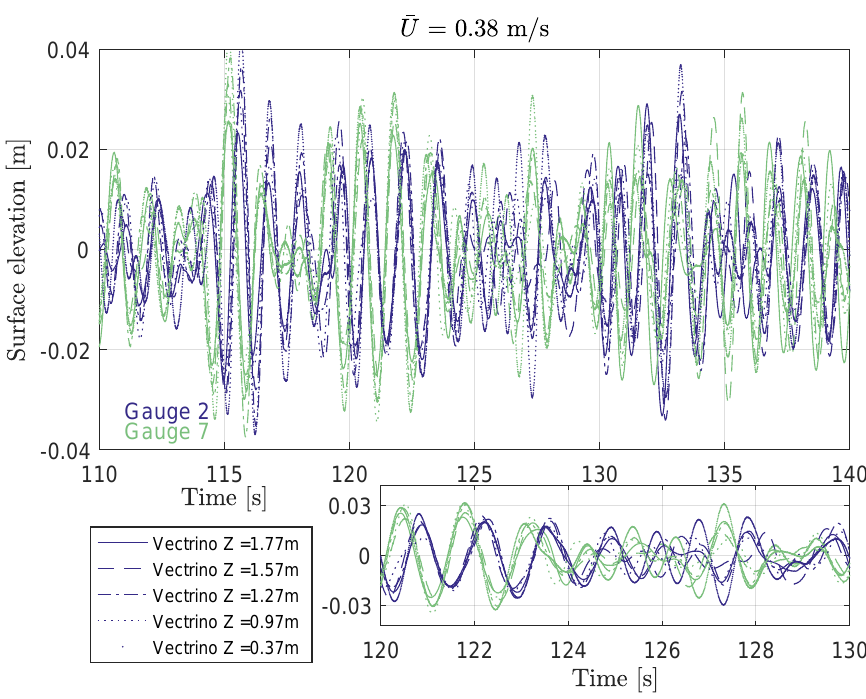
Figure 8. Example time series of irregular wave, Sea State 6, shown with five repeats. Gauges 2 and 7 are displayed on the graph. Wave Repeats 1–5 correspond to five z -positions of the Vectrino as shown in the